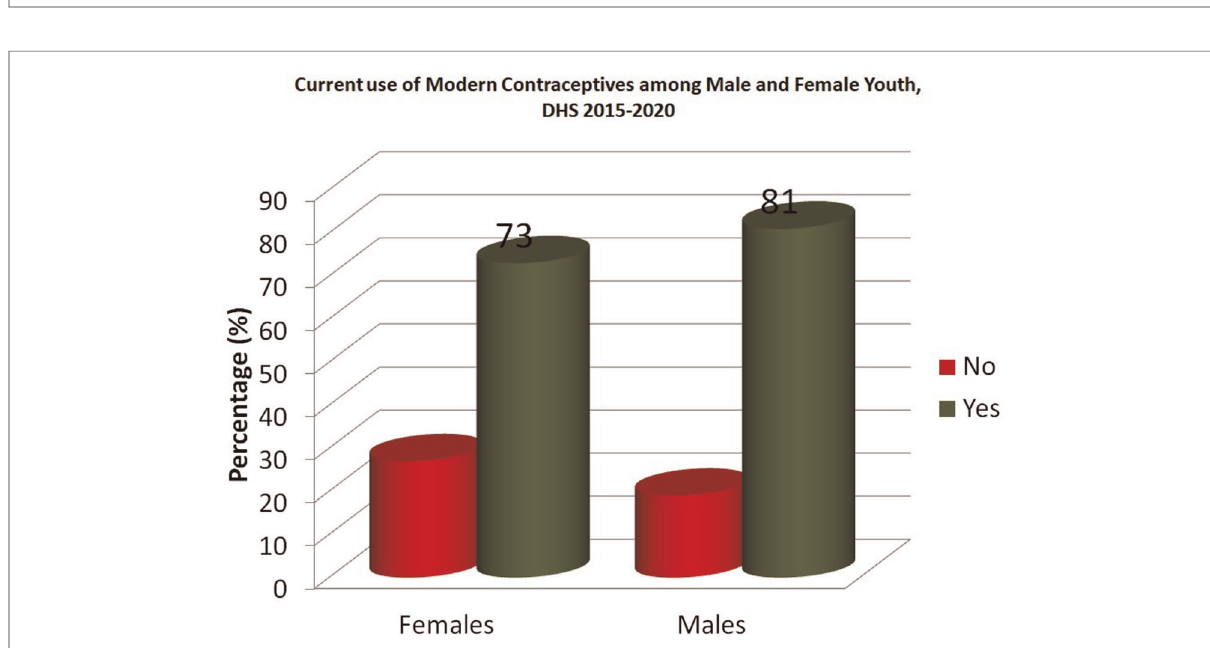
FIGURE 2 Levels of contraceptive method knowledge among youth by gender.